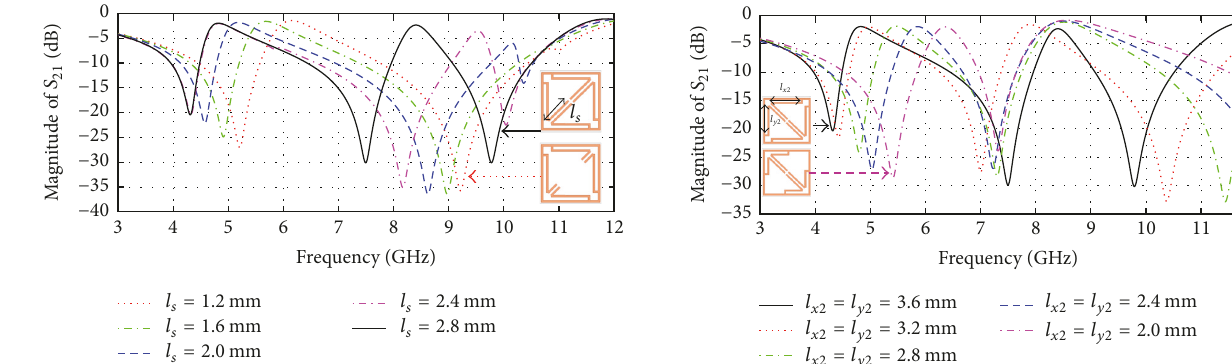
Figure9:Effectofvariationsinpositionofshortingstub 𝑠 1 ,𝑠 2 (𝑙 𝑥2 , 𝑙 𝑦2 ) on 𝑆 21 resonances.